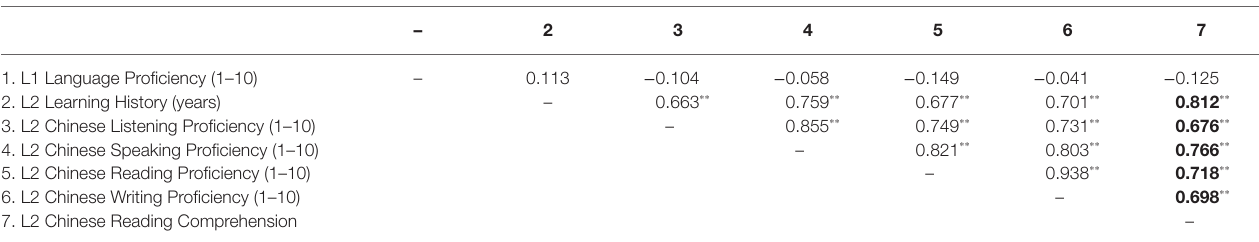
TABLE 4 | Pearson Correlations between language background and L2 Chinese reading comprehension.